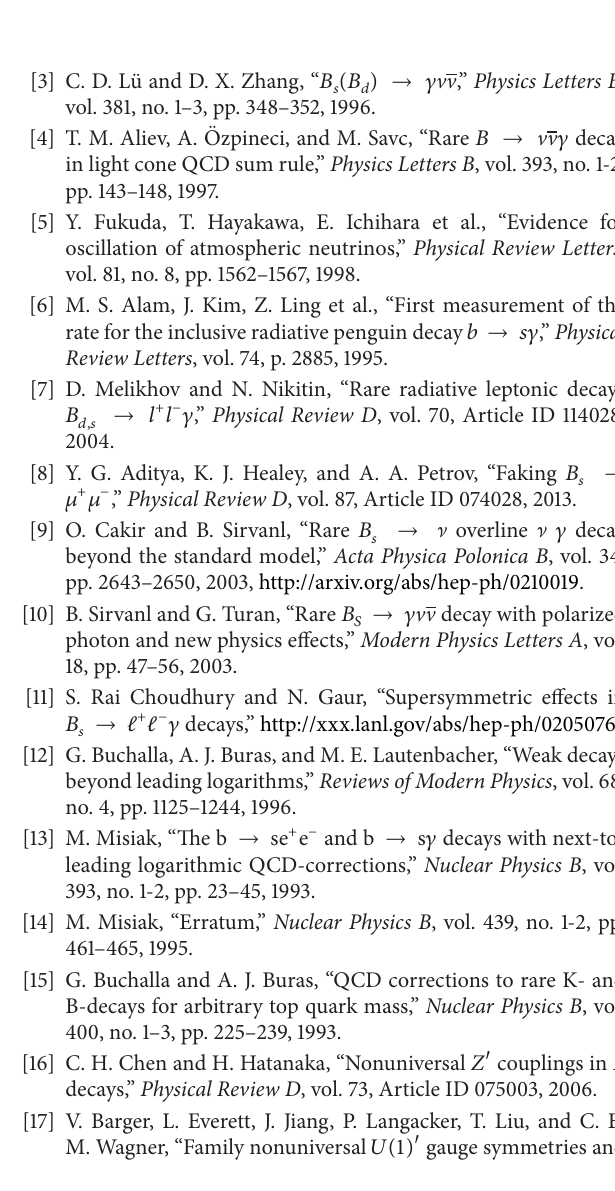
Figure 1: The dependence of the integrated branching ratios BR (1) and BR (2) for the 𝐵 𝑠 → 𝛾 ]] decay. The superscripts (1) and (2) indicate the photon in positive and negative helicity state, respectively.